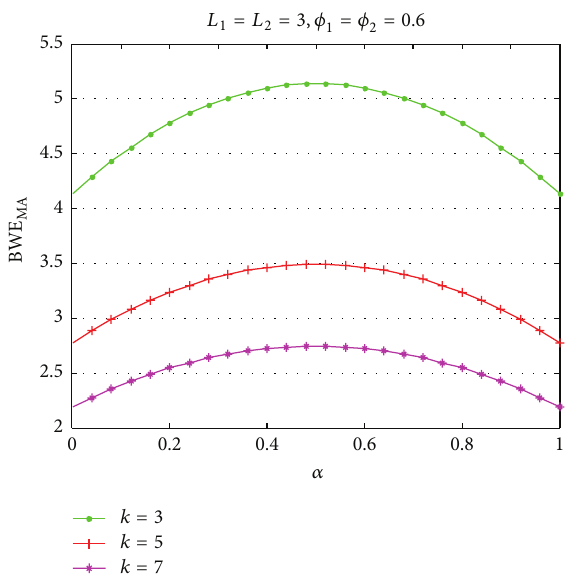
Figure 10: Impact of 𝜙 1 on bullwhip effect for different 𝛼 under the